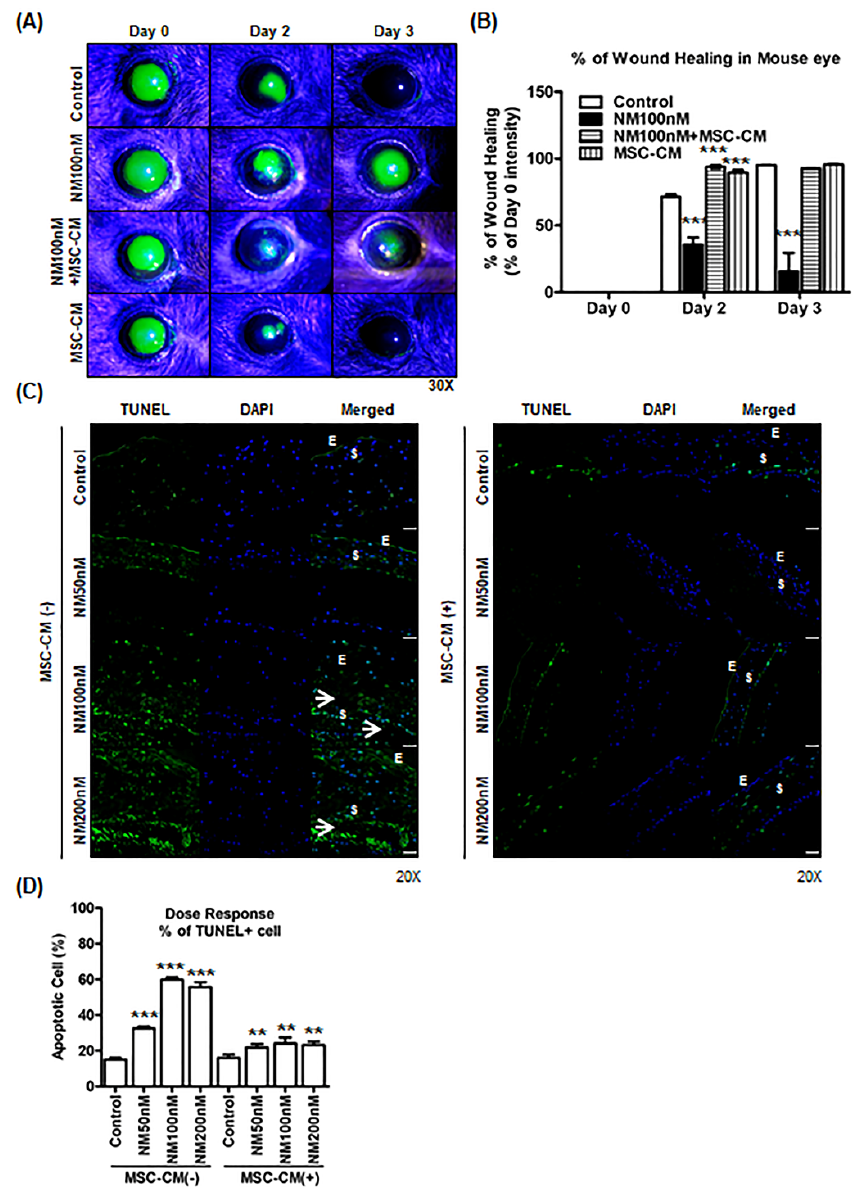
Figure 5. Wound healing effect of MSC-CM on NM injury on mouse corneas. ( A ) Representative images of mouse corneas (n = 4/group) showing fluorescein staining after epithelial scratch and topical application of 10 μ L of NM 100 nM on the center of cornea for 30 min. After 30 min, corneas were washed with 1 mL of 1X PBS, and corneas were applied with MSC-CM twice a day for 3 days. ( B ) Relative fold changes of comparing epithelial defect area between groups at Day 0 to Day 3 (n = 4/group) from Figure 5A. *** p < 0.001 vs. untreated control (Day 2) or untreated control (Day 3). ( C ) Ex vivo mouse eye culture model: For apoptotic cell death, mouse eyes were cultured in various doses of NM (50, 100, and 200 nM) in KSFM media for 2 h and washed two times with 1X PBS. After washing, NM-exposed mouse eyes were replaced with ( B ) or without ( A ) MSC-CM for 2 days and imaged using 20× magnification im-immunofluorescence by TUNEL assay. TUNEL (Green), DAPI (Blue). Scale bar, 50 μ m ( D ) Graphs showing apoptotic cell death on mouse cornea area from Figure 5C. *** p < 0.001 vs. untreated control (MSC-CM-), ** p < 0.01 vs. NM treated group (MSC-CM-). Microscopic analysis of murine eyes showed corneal epithelial and stromal edema upon NM exposure compared with control (Control, 51.1 ± 9.5 μ m; NM 50 nM, 131.3 ± 25.9 μ m; NM 100 nM, 212.5 ± 44.3 μ m; and NM 200 nM, 212.5 ± 23.1 μ m) (Figure 6A). NM caused a loss of corneal endothelial cells and endothelial barrier integrity at Day 2 post-